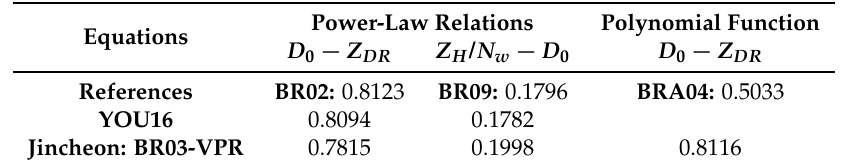
Table 4. Correlation coefficients between DSD parameters ( D 0 and Z H / N w ) fitted in different equations of D 0 − Z DR and Z H / N w − D 0 at the Jincheon